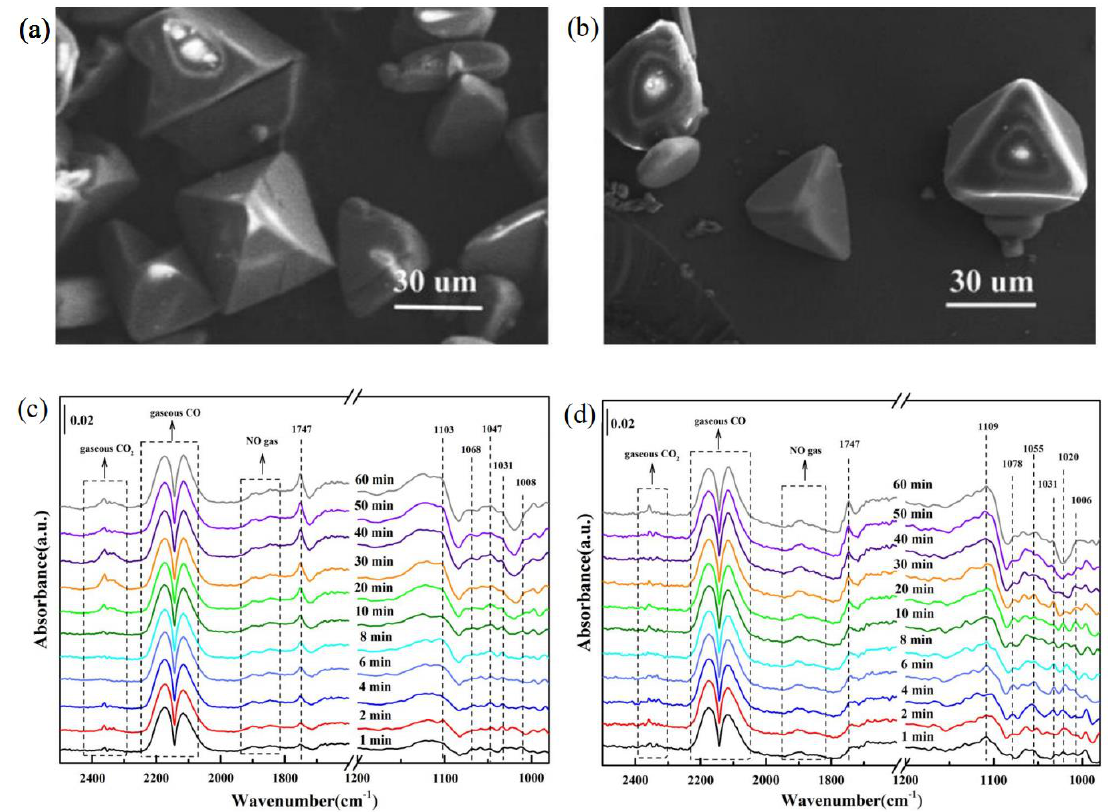
Figure 2. SEM images of ( a ) Cu-BTC and ( b ) Ce-Cu-BTC. In situ DRIFTS spectra of CO + NO + O 2 co-adsorption on the surface of ( c ) Cu-BTC and ( d ) Ce-Cu-BTC at 150 °C , where NO = 1000 ppm, CO = 1000 ppm, 5 vol.% O 2 , and equilibrium gas was N 2 . Reproduced from [37] with permission.